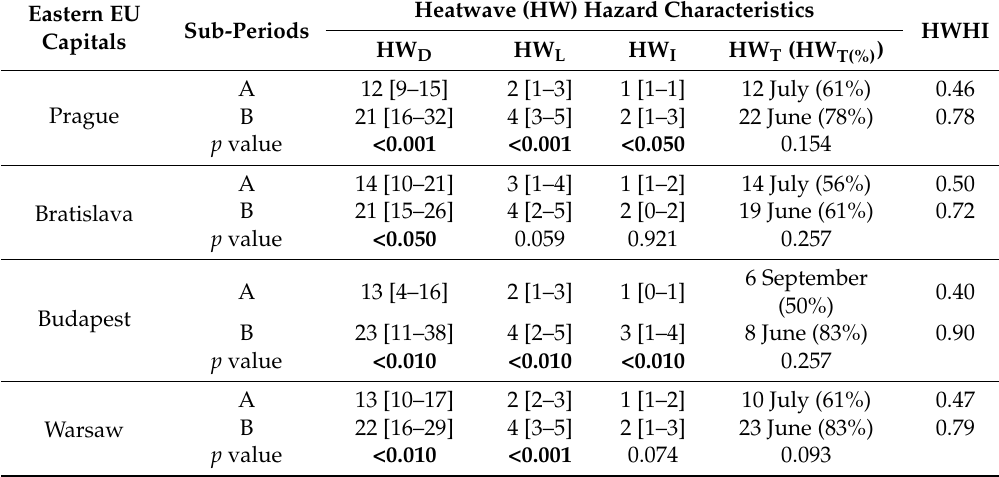
Table 7. The median of heatwave (HW) hazard characteristics (HW D : HW days; HW L : long HWs; HW I : high-intensity HWs; HW T : the timing of the first simultaneously long and high-intensity HW) and the value of the Heatwave Hazard Index (HWHI) referred to the 1980–1997 (A) and the 1998–2015 (B) 18-year sub-periods for eastern EU capitals. The 75th and 25th percentiles of HW D , HW L and HW I (in square brackets) and the frequency of years with at least one simultaneously long and high-intensity HW (HW T(%) in round brackets) are shown. The significance level ( p value) of associations between the two 18-year sub-periods are shown (bold when